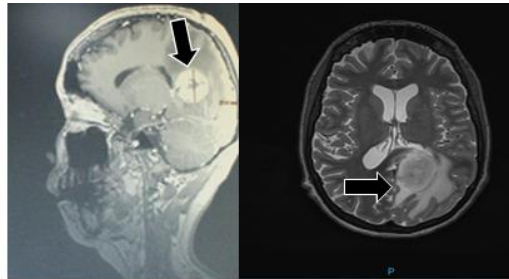
Figure 3 . Magnetic Resonance Image showing brain tumor in axial and sagittal section